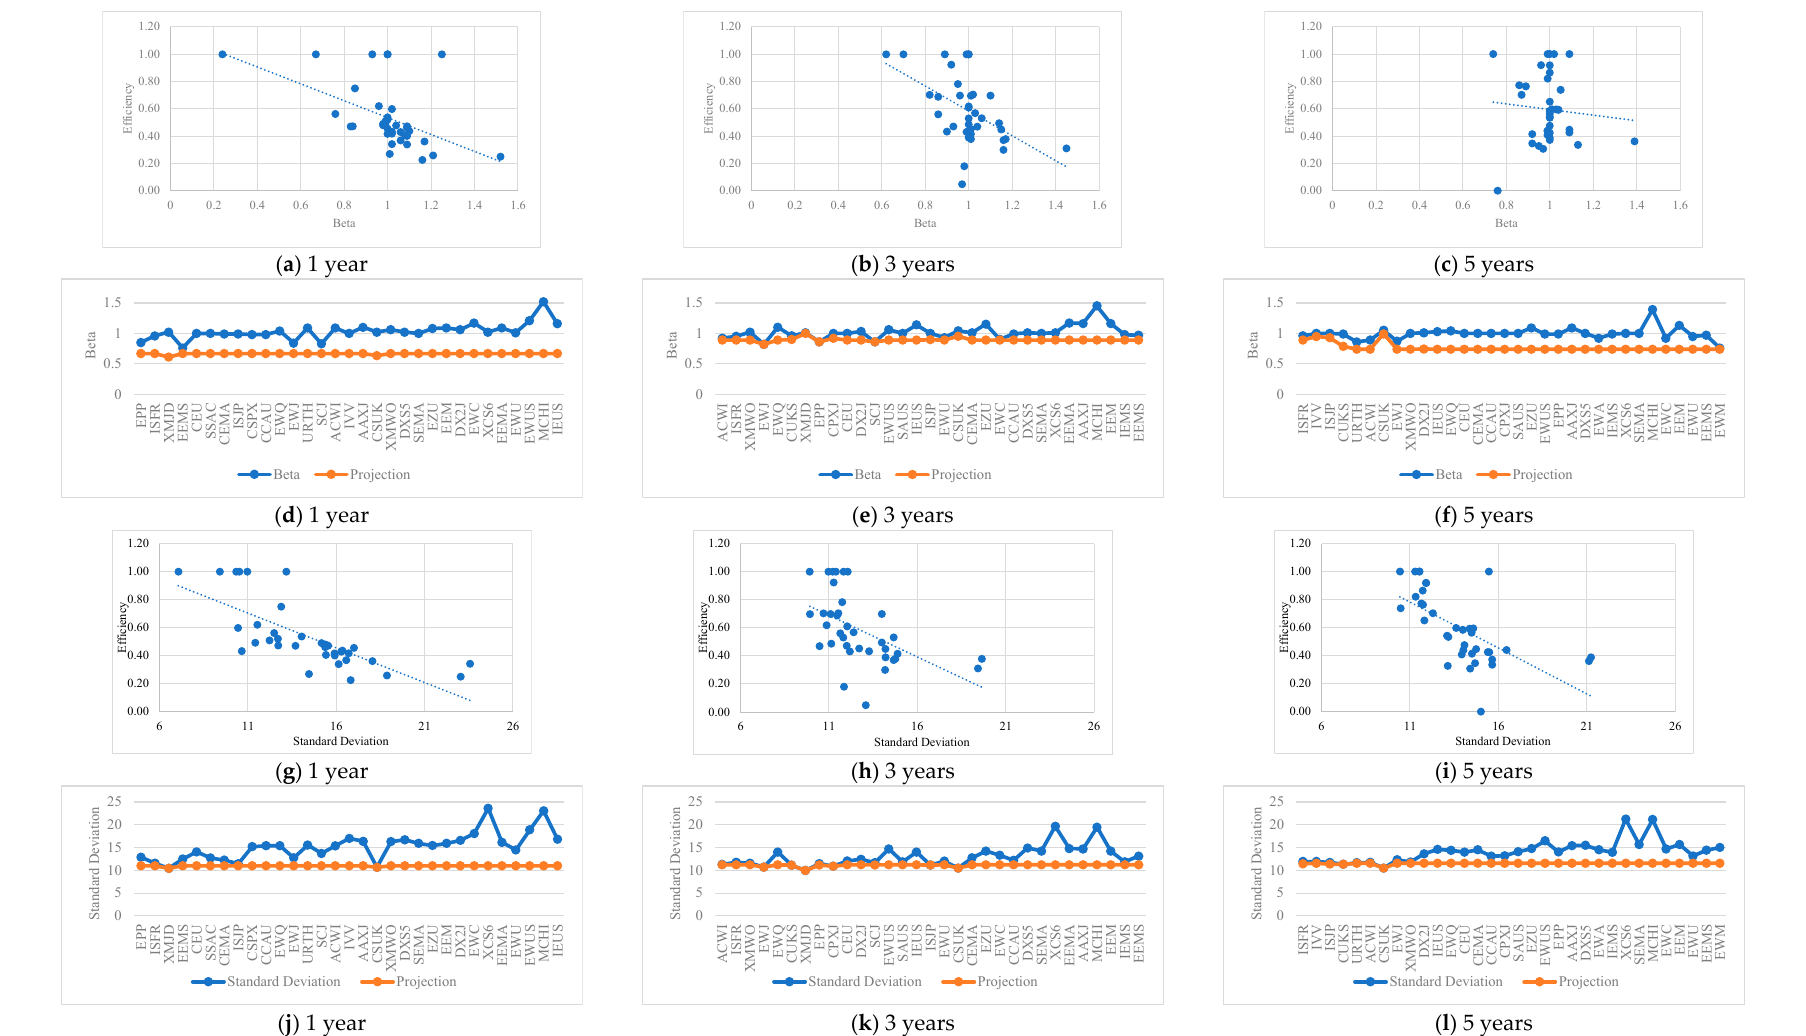
Figure 7. Efficiency scores vs. inputs and projections (ETFs are ordered in decreasing order of efficiency) for the different time horizons–M4.